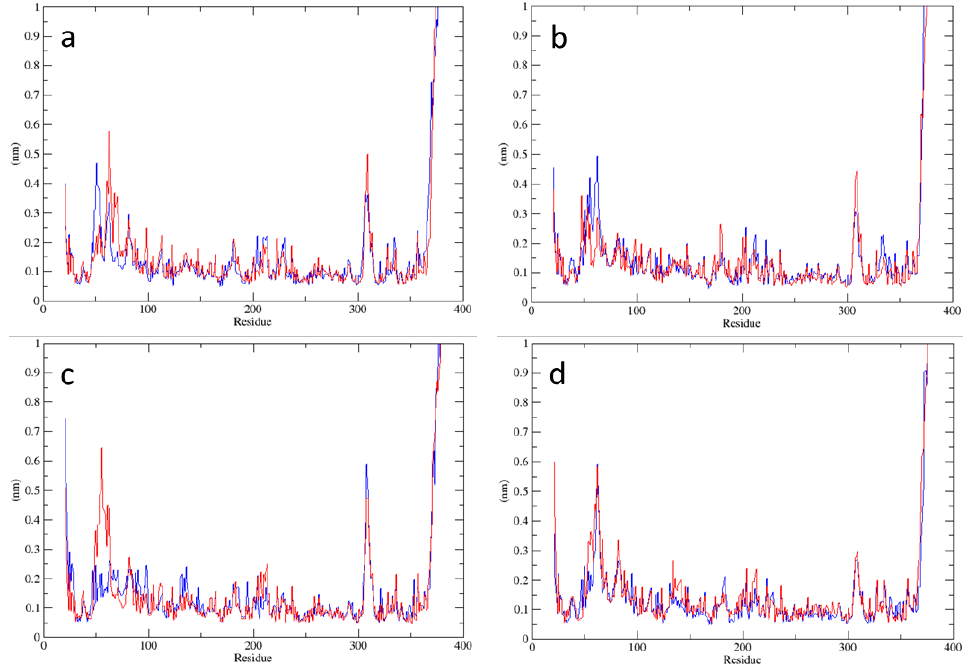
Figure 2. RMSF analysis for simulations at 310 K of: ( a ): wtGALT; ( b ): p.Gln188Arg; ( c ) wtGALT + G1P + H2U; ( d ) p.Gln188Arg + G1P + H2U. Blue lines represent RMSF fluctuation of chain A, red lines of chain B.